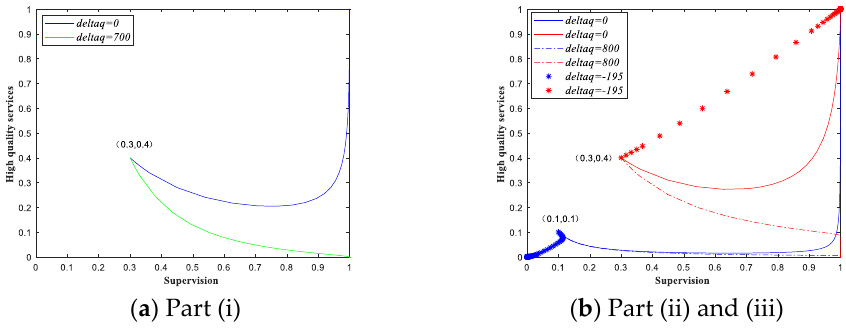
Figure 4. Evolutionary paths of Scenario 3 under demand disturbance.